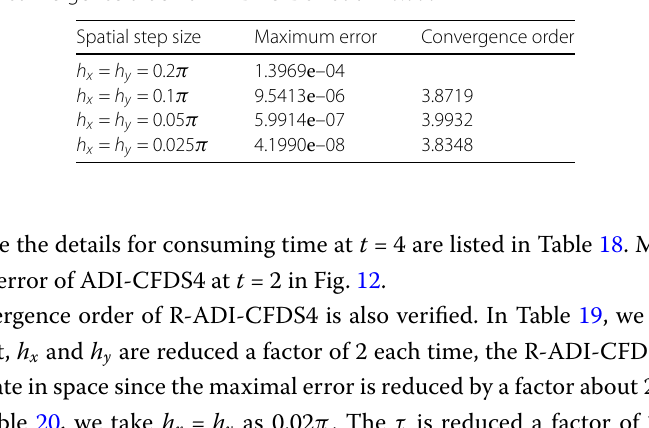
Table 19 The convergence order for R-ADI-CFDS4 at τ = 0.0001